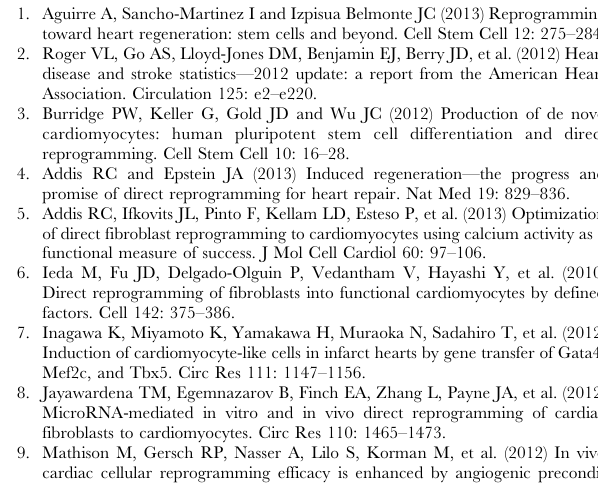
treatment (bottom row) for the indicated proteins. Scale